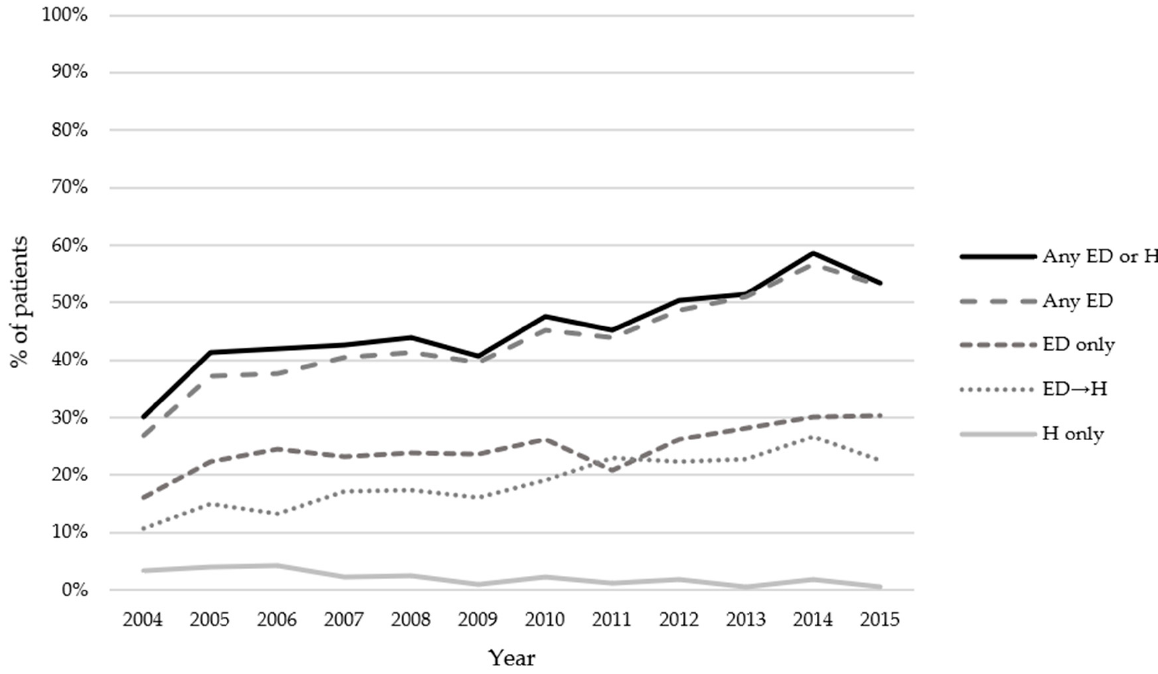
Figure 2. Percentage of patients experiencing acute care use in the year they received chemotherapy. Logistic Regression Models for ED and ED → H